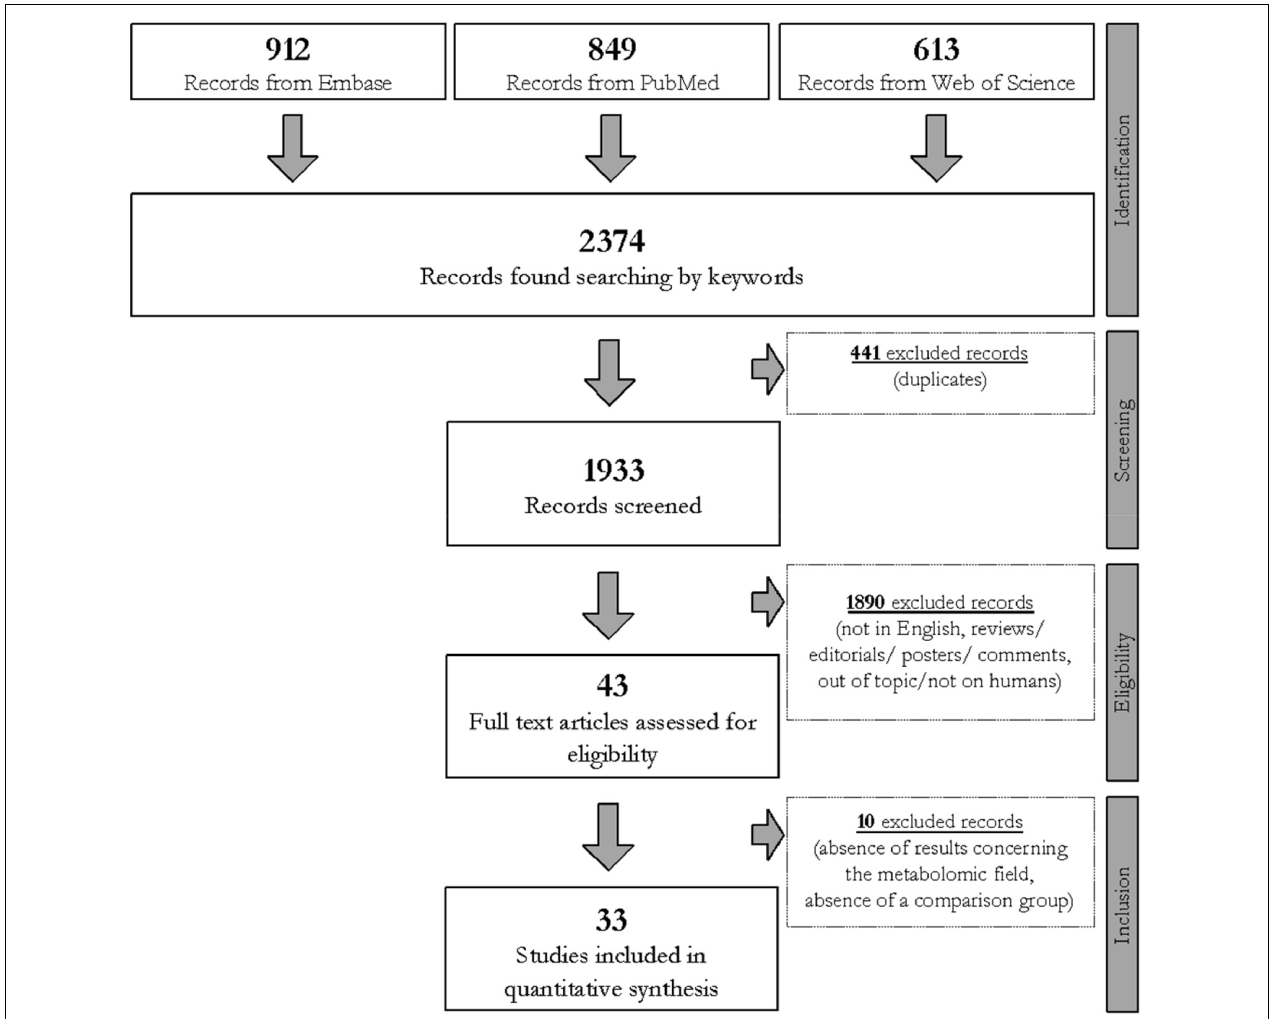
FIGURE 1 | Flowchart of the study selection process carried out using Preferred Reporting Items for Systematic Reviews and Meta-Analyses (PRISMA) process (Shamseer et al., 2015) based on the query line: (celiac OR coeliac) AND “disease” AND (“metabolomic” OR “metabonomic” OR “metabolome” OR “metabolite” OR “biomarker”) AND (“gluten” OR “diet”)